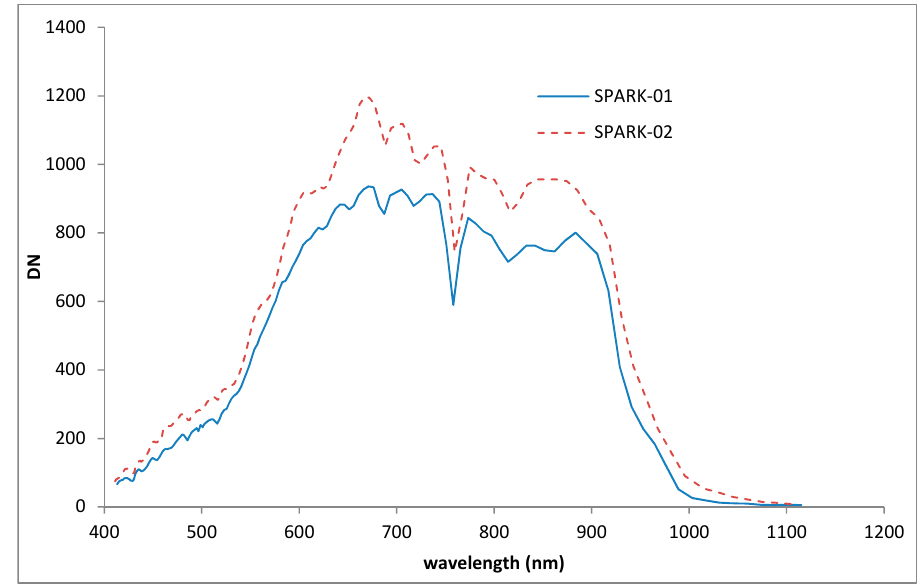
Figure 12. DN curves from SPARK-01 and -02 at the Dunhuang calibration site, averaged over 6 × 6 pixels.